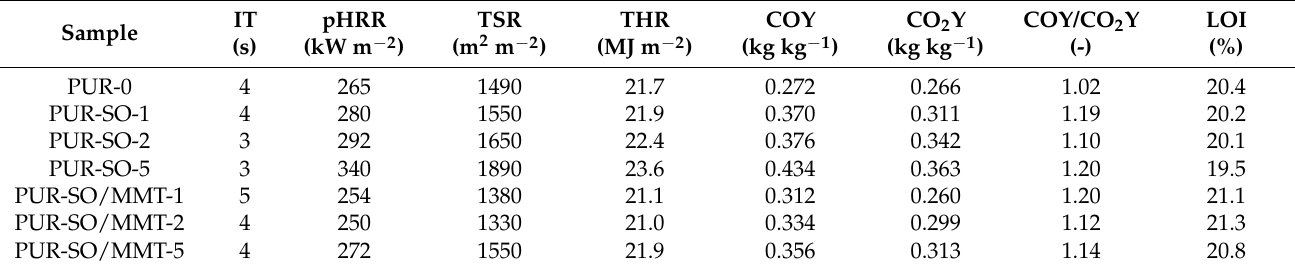
Table 3. The results of the cone calorimeter test.